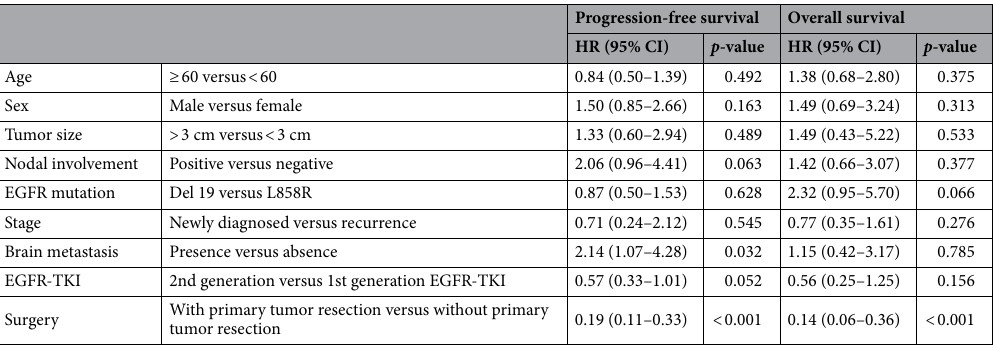
Table 2. Cox proportional hazards regression for progression-free survival and overall survival of all patients. EGFR epidermal growth factor